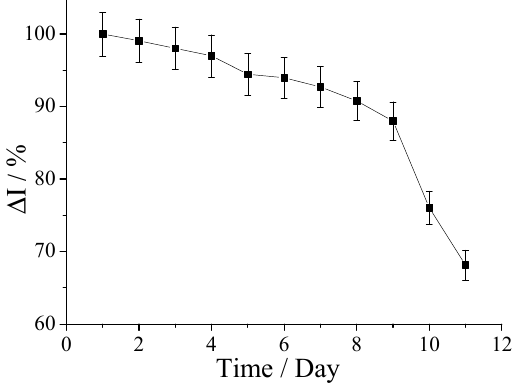
Figure 11. Inspection of sensor stability.